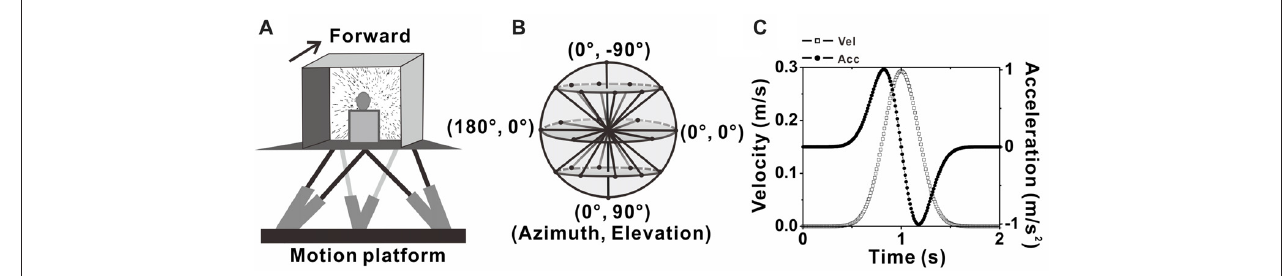
FIGURE 1 | Experimental setup and transient translation stimuli. (A) Schematic illustration of the virtual reality apparatus. Monkeys were seated on a motion platform, with six degrees of freedom, which provided the vestibular stimulus. Visual stimulus (optic flow) was displayed on the screen located in front of the monkey. (B) Illustration of the 26 movement trajectories used to measure 3D heading tuning curve, corresponding to all combinations of azimuth and elevation, in 45 ◦ increments from a sphere. (C) Motion Profile. All movements had a 2 s duration, originated from the center position, and had a Gaussian velocity profile (peak of 0.3m/s, dashed-square line) with a corresponding biphasic linear acceleration profile (peak of ± 1 m/s 2 , dashed-dot